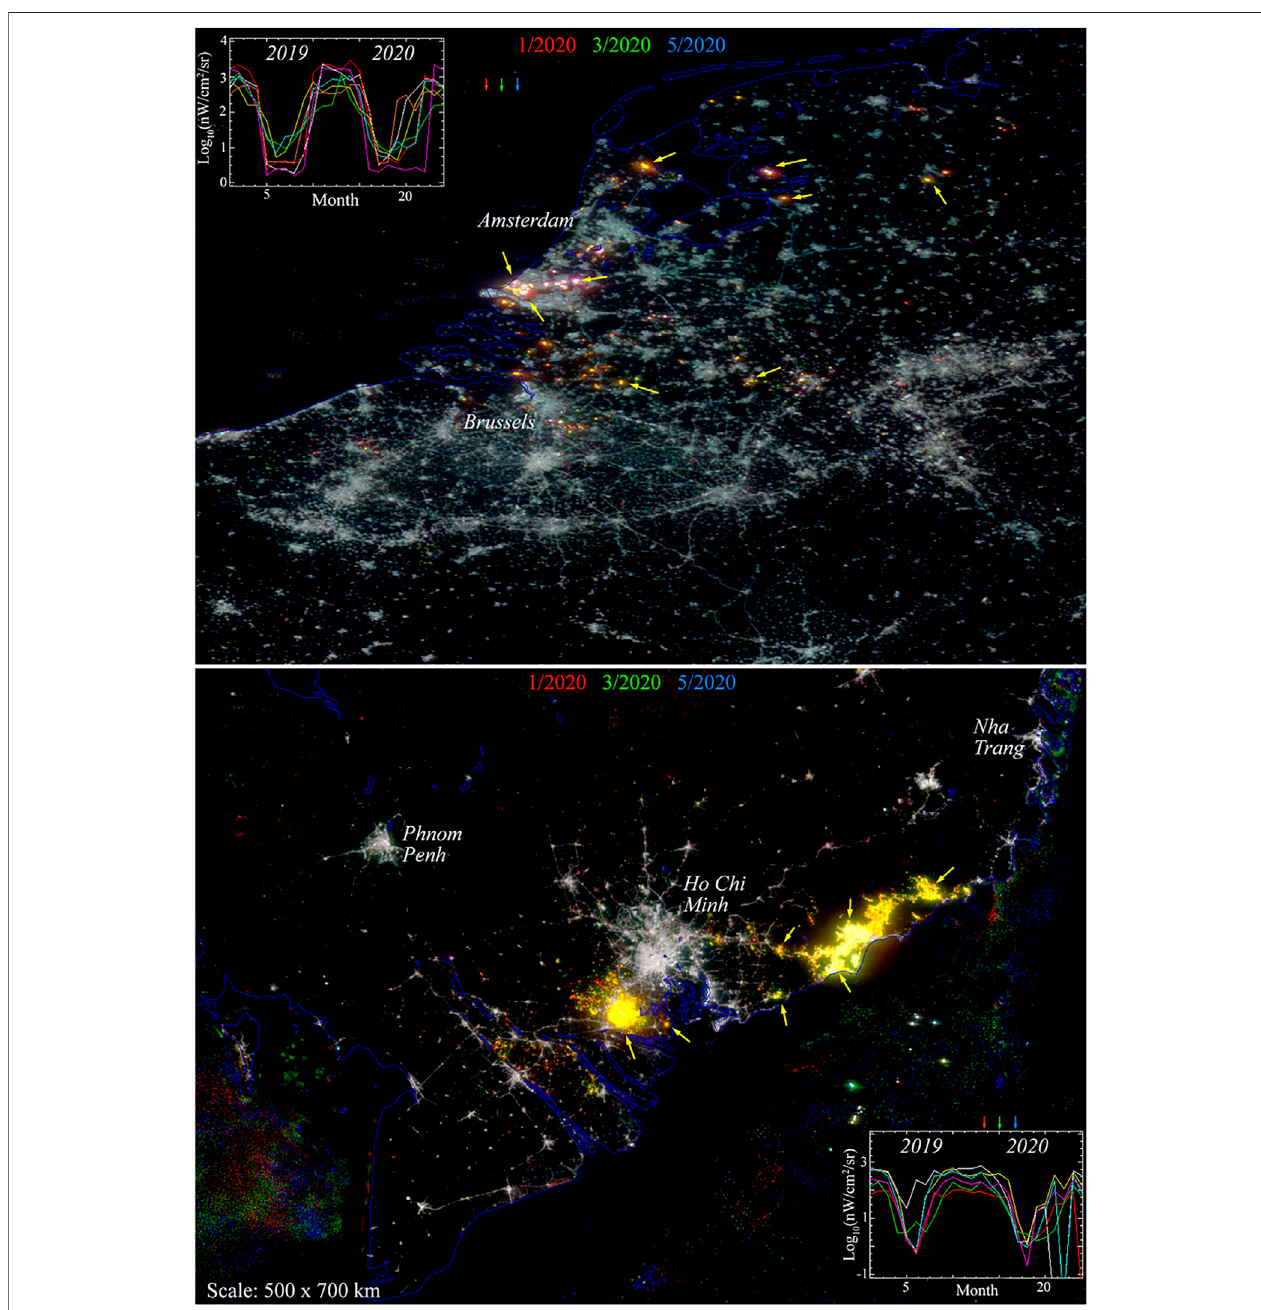
FIGURE 9 | Nocturnal horticulture. Tri-temporal composites of monthly mean radiance shows urban lights as unchanging (shades of gray). Color implies change. Warmer colors imply dimming between January and May 2020. Isolated sites of greenhouse clusters in the Netherlands and Belgium (top) and extensive Dragonfruit plantations in southern Vietnam (bottom) are seasonally lighted in 2019 and 2020 (arrows and inset plots).